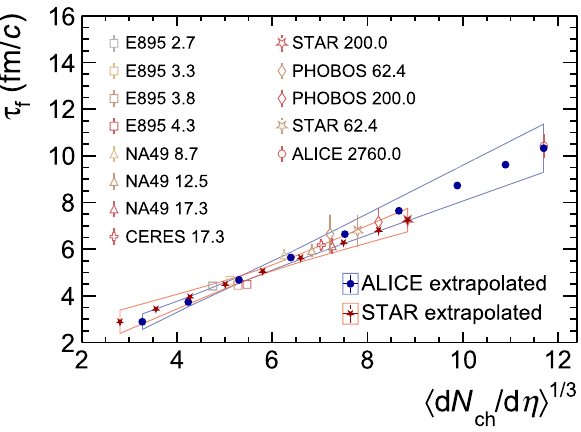
Fig. 1 Open symbols: Compilation of decoupling (freeze-out) times, τ f , plotted as a function of the cubic root of the charged particle den- sity, (d N ch /d η) 1 / 3 , observed in various collision systems and for a wide range of beam energies [26]. Filled symbols: extrapolated values of τ f corresponding to each of the centrality classes used in our computa- √ s NN = 0 . 2 TeV and Pb–Pb tion of η/ s based on Au–Au collisions at √ s NN = 2 . 76 TeV, measured by the STAR and ALICE collisions at collaborations, respectively. Red/blue solid lines represent systematic uncertainties of the polynomial fits to the data